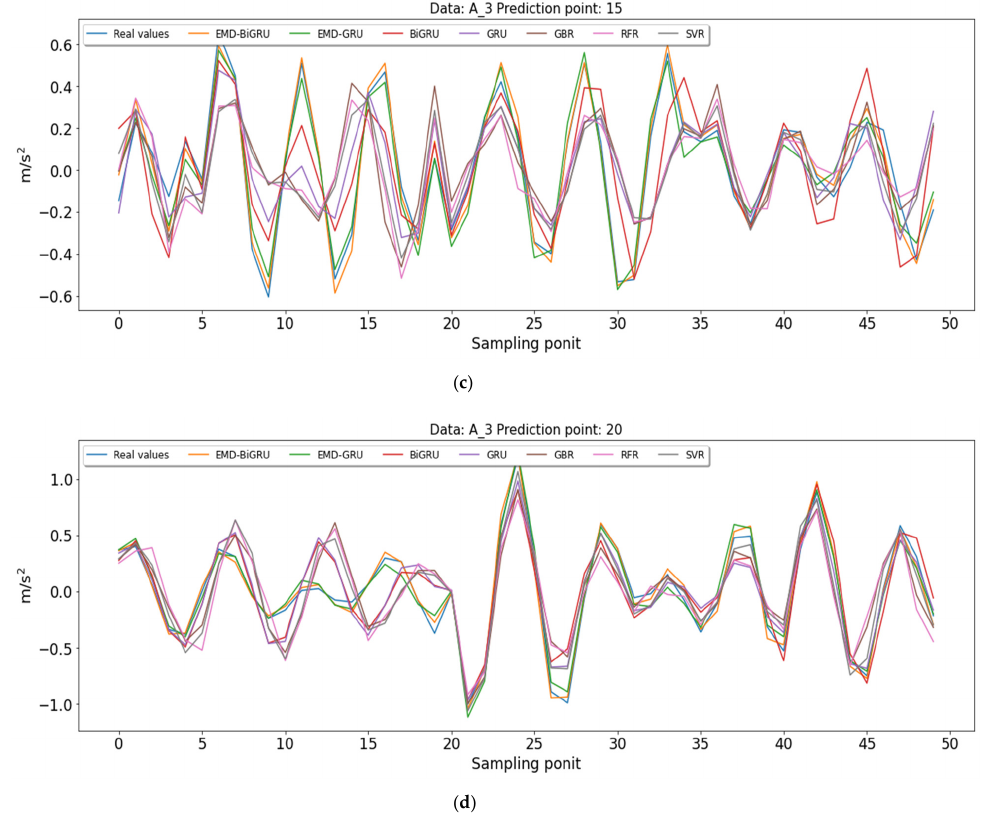
Figure A2. Comparisons results for different data sets using various algorithms. ( a ) Comparisons of predicted results for the A_3 data set using different algorithms (points 5). ( b ) Comparisons of predicted results for the A_3 data set using different algorithms (points 10). ( c ) Comparisons of predicted results for the A_3 data set using different algorithms (points 15). ( d )Comparisons of predicted results for the A_3 data set using different algorithms (points 20). The predicted results for A_4 data sets using seven algorithms, including EMD- Table A3. Comparison results for data set A_4 using different algorithms.